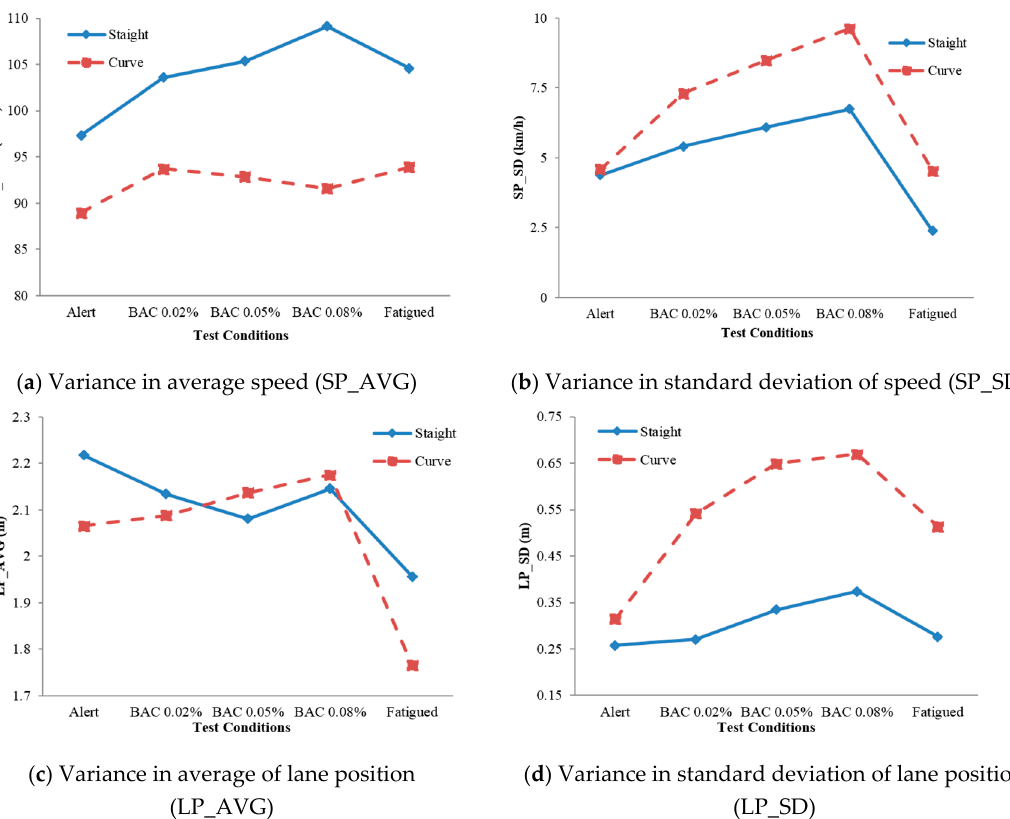
Figure 4. Variance in driving performance under straight and curve segments [17]. Note: ( a ) Variance in average speed (SP_AVG); ( b ) Variance in standard deviation of speed (SP_SD); ( c ) Variance in average of lane position (LP_AVG); ( d ) Variance in standard deviation of lane position